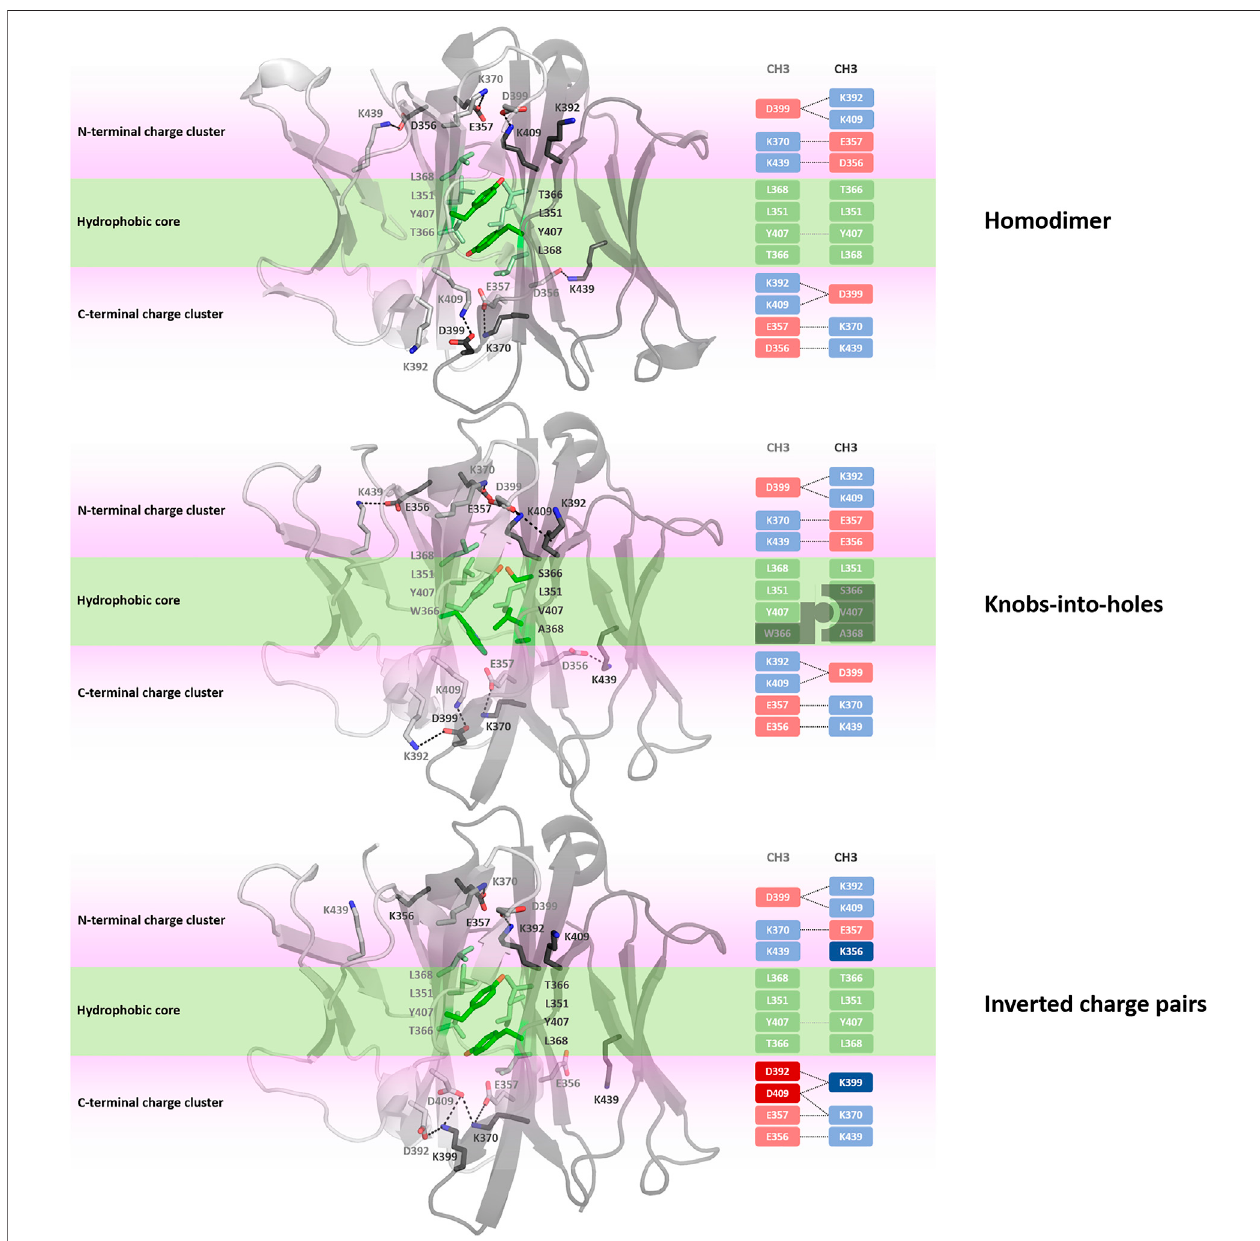
FIGURE 8 | Interface interaction analysis of the homodimer and two heterodimers following different design strategies, i.e., knobs-into-holes (PDB: 4NQS) and chargeinversion(PDB:5DK2).TheC H 3-C H 3dimersconsistofahydrophobiccoreatthecentreoftheC H 3-C H 3interface(illustratedinpalegreen)andtwohighlycharged regions (N-terminal charge cluster and C-terminal charge cluster), shown in light pink, that stabilize the